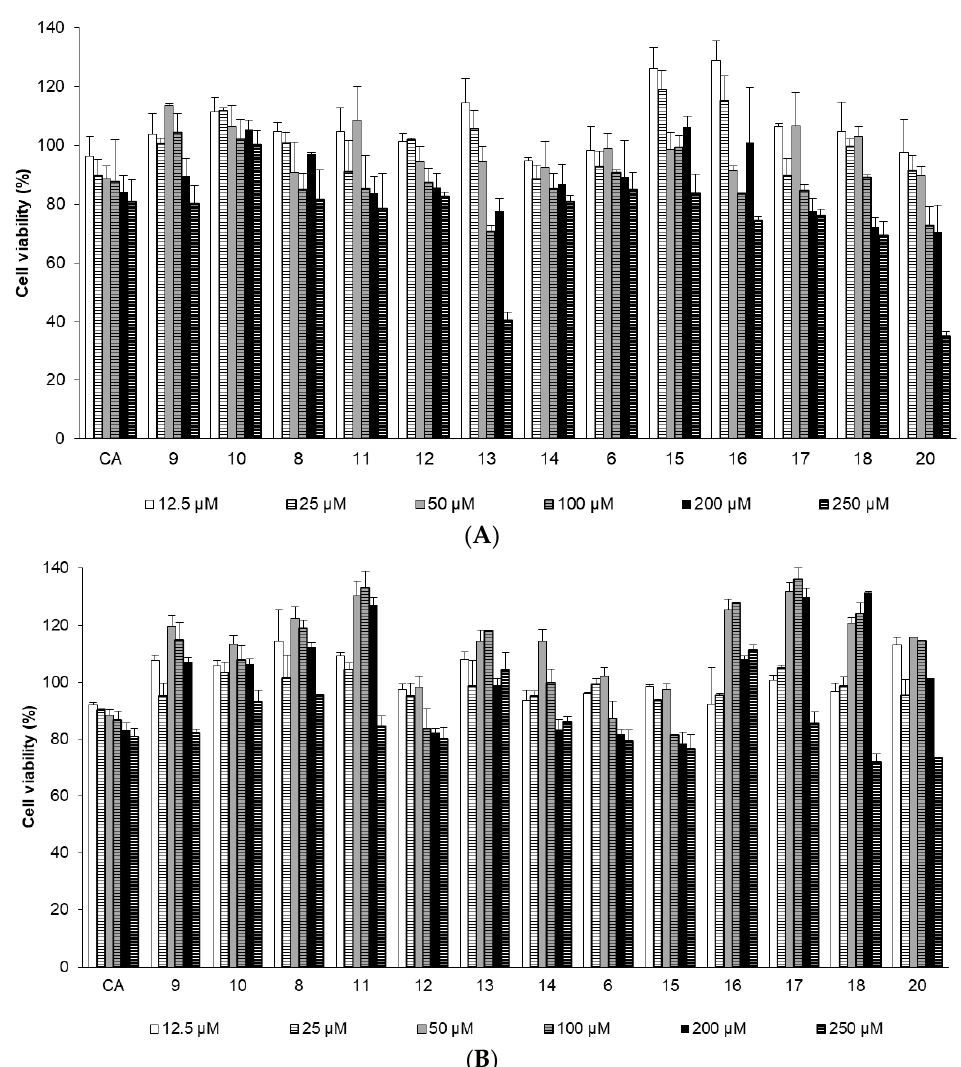
Figure 1. Cell viability in normal human dermal fibroblast (NHDF) cells after 24 h ( A ) and 48 h ( B ) exposure to different concentrations of CA and its derivatives. The cell viability was evaluated with MTT assay and the results were presented as the percentage of the control groups. The data are presented as the mean standard deviation (SD) of three independent experiments.